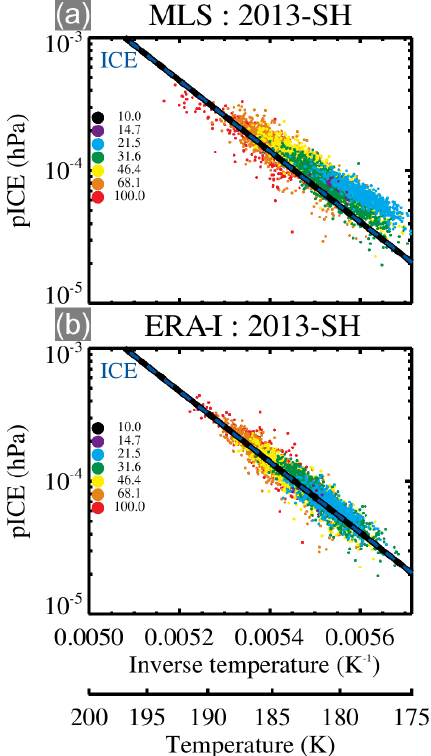
Figure 12. Temperature variation of the estimated partial pressure of water vapor over ice, p ice , determined from the product of the MLS H 2 O volume mixing ratio and the total atmospheric pressure, for Antarctic ice PSCs in 2013. The pressure levels (hPa) are color coded and given in the legend. (a) MLS temperature. (b) ERA-I temperature. The blue–black dashed lines indicate the theoretical equilibrium p ice as a function of the frost point temperature.